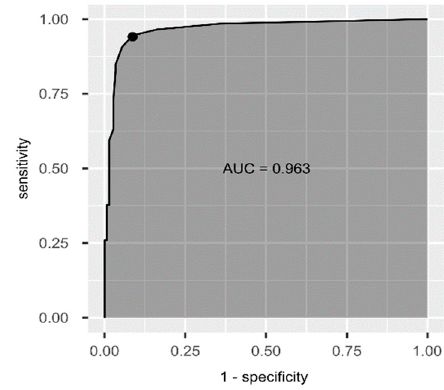
Figure 2. ROC curve of the Slovak EAT10 ® .